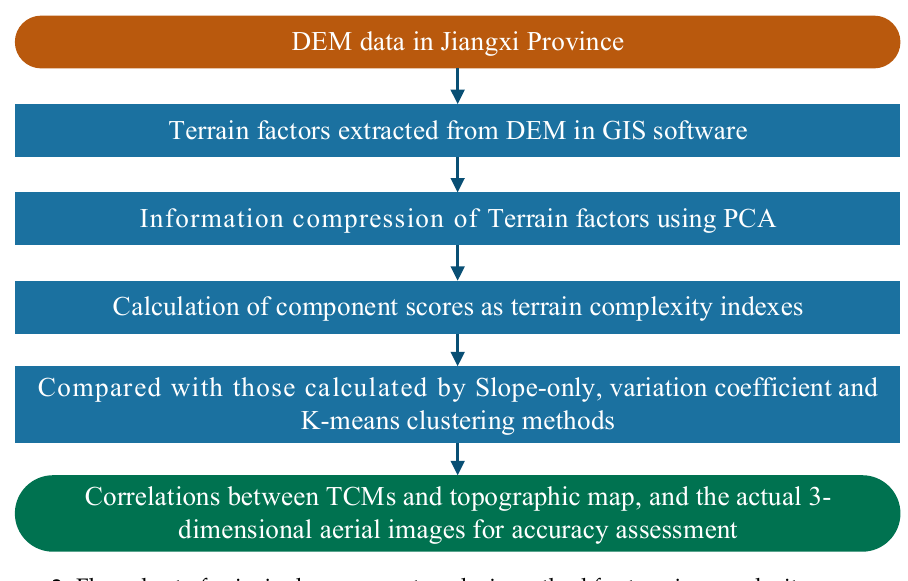
Figure 3. Flow chart of principal component analysis method for terrain complexity assessment.